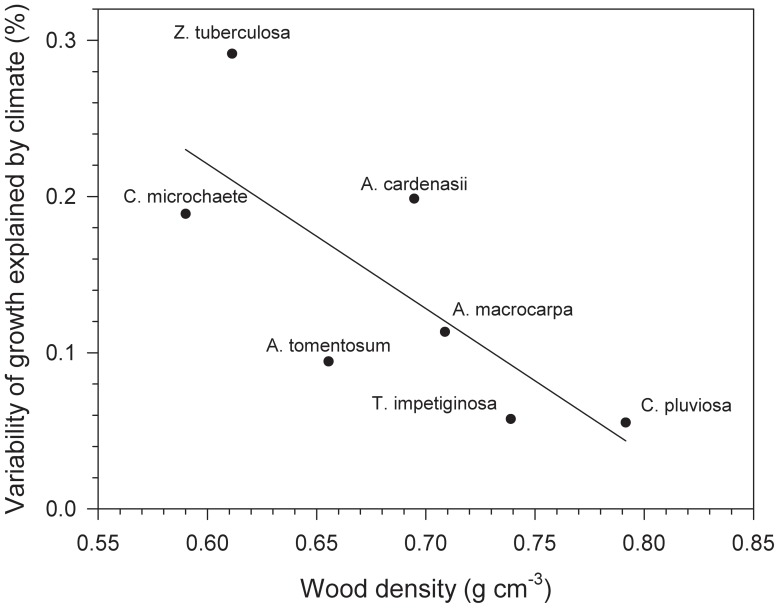
Wood density is negatively related to growth variability driven by water balance.The amount of basal area increment variance (R2) explained by the best linear mixed-effects models fitted as a function of soil water balance is shown in the y axis (see Table 4).